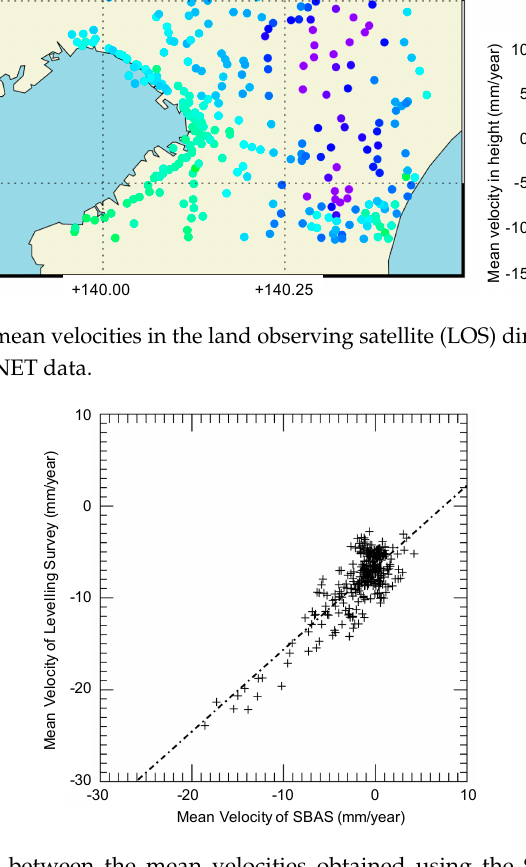
Figure 8. Comparison between the mean velocities obtained using the SBAS method and the levelling data.